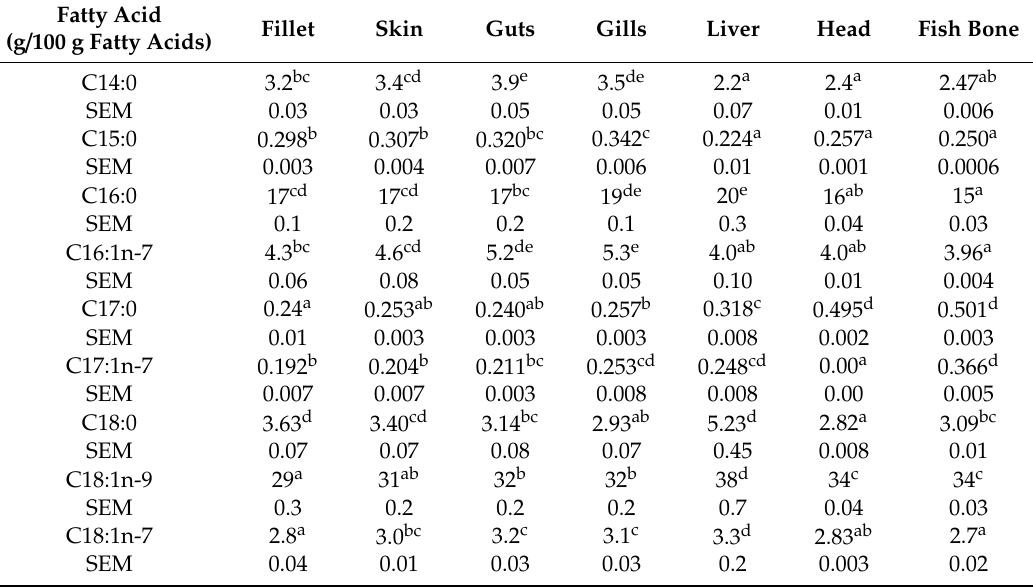
Table 4. Fatty-acid profile of sea bass fillet and